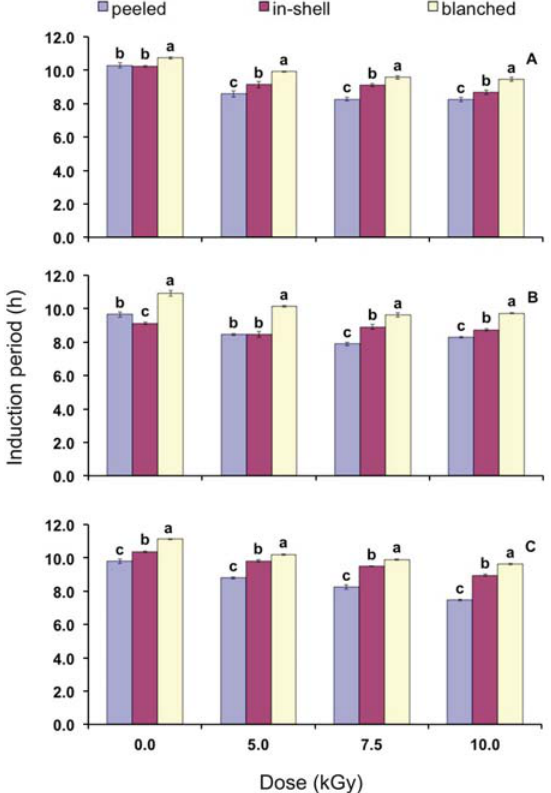
Figure 3. Induction period (h) of oils extracted from peeled, in-shell and blanched peanuts on time zero ( A ), after three ( B ) and six months storage ( C ). Error bars represent standard deviations of triplicate measurements. Means with the same letter within a gamma radiation dose are not statistically different by Tukey’s multiple test ( p <